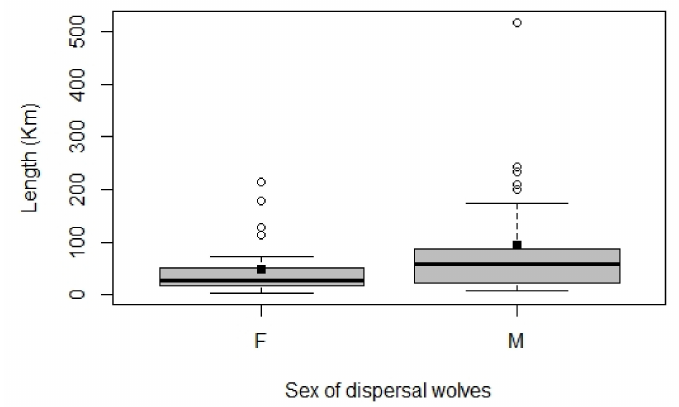
Figure 2. Boxplot of dispersal distances by sex. The highlighted bar represents the median of the sample, the width of the box is the interquartile range (IQR). Outliers are indicated with circles. Black squares indicate the mean.